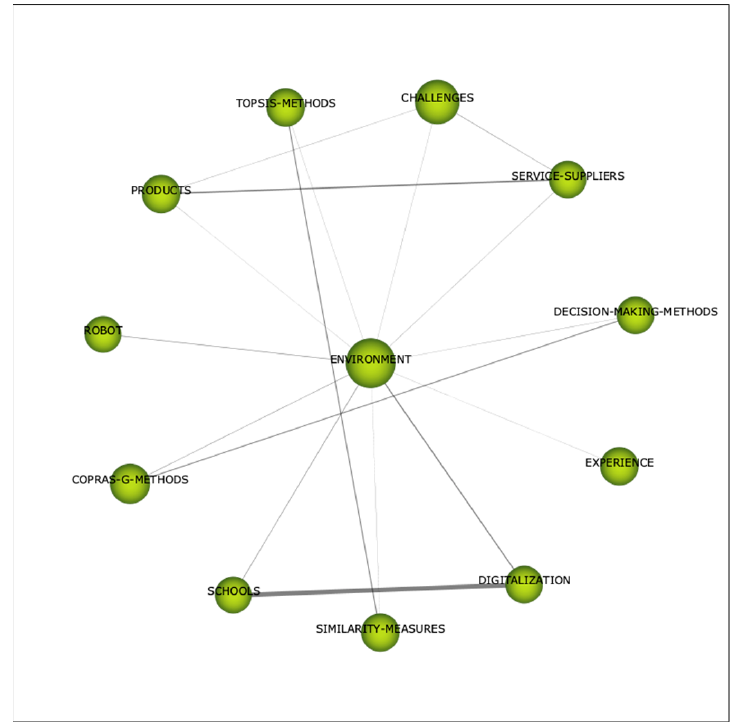
Figure A1. Environment cluster network.